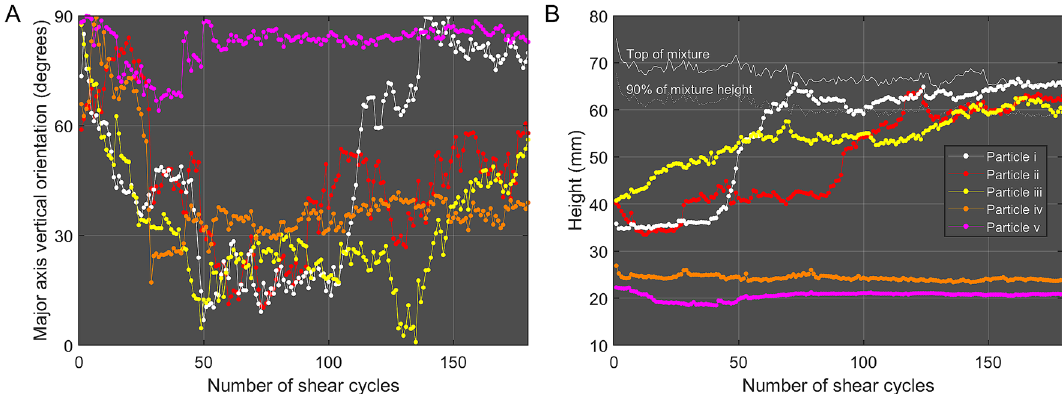
Figure 3. Dynamics of the five selected Brazil nuts (i to v) as a function of number of shear cycles: ( A ) Particle orientation measured relative to the vertical; ( B ) Height of the particle centroid from the bottom of the